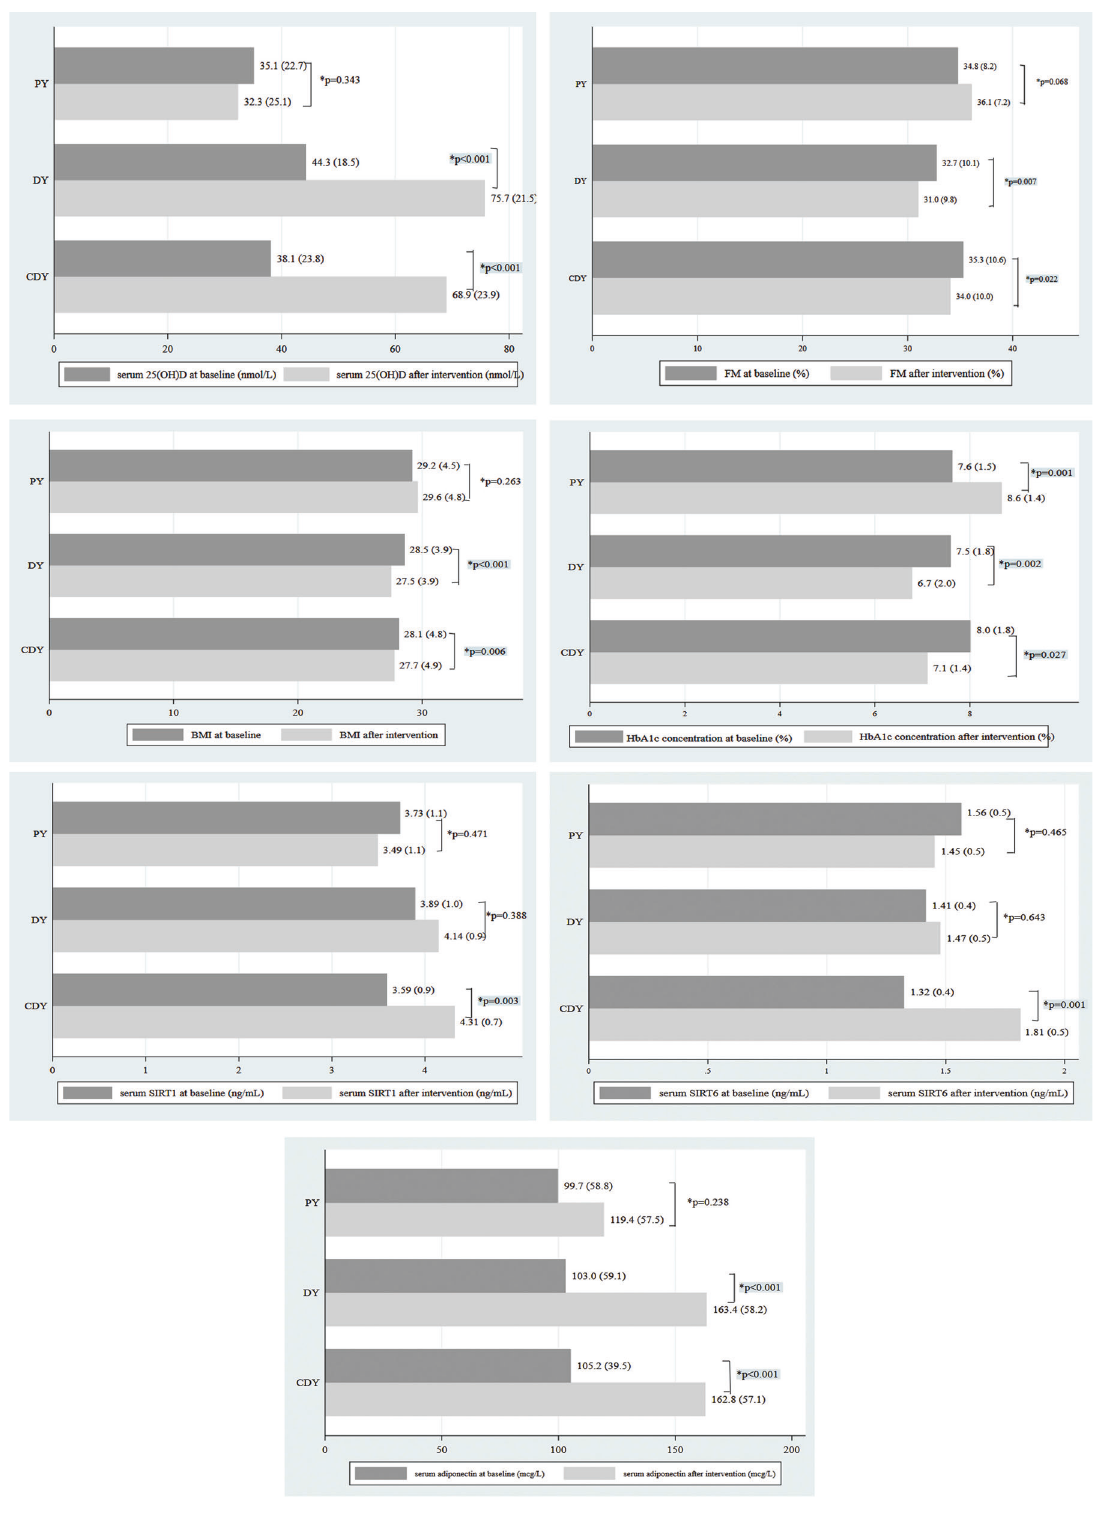
Fig. 1 Comparison of mean variables in groups over time. *: Within-group comparison. FM Percent of total body fat mass, HbA1c hemoglobin A1c, 25(OH)D 25-hydroxycalciferol, SIRT blood lipid concentrations and improved oral glucose tolerance [49]. documented that both inhibition and enhancing SIRT6 may improve On the other hand, experimental studies provided strong evidence glucose tolerance in T2D. In the murine model of T2D, inhibition of for SIRT6 in pancreatic β -cells function [50, 51]. Notwithstanding, our SIRT6 for ten days resulted in over-expression of muscular GLUT-1 fi ndings provide clinical evidence for vitamin D-induced increased and GLUT-4, enhanced glycolysis, decreased serum insulin as well as